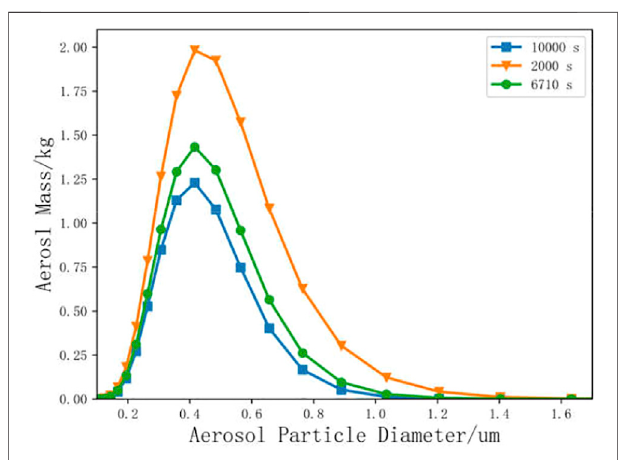
FIGURE 9 | Distribution of the CsI aerosol mass.